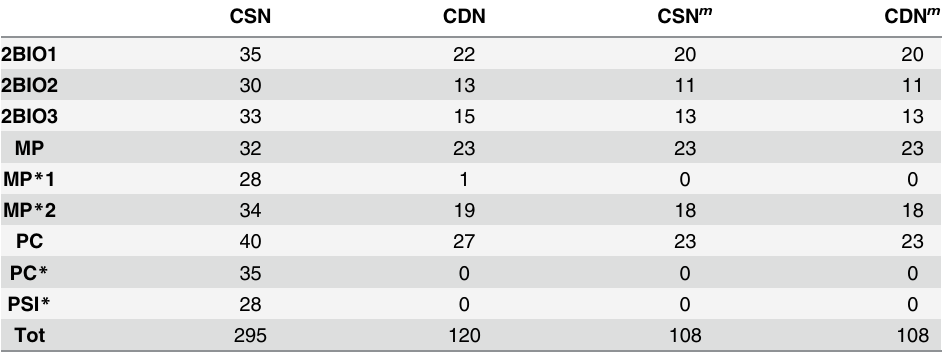
Table 1. Comparison of network properties. Number of nodes in each class in the contact sensors network and in the contact diaries network in the original (respectively CSN, CDN) and the matched forms (respec- tively CSN m , CDN m